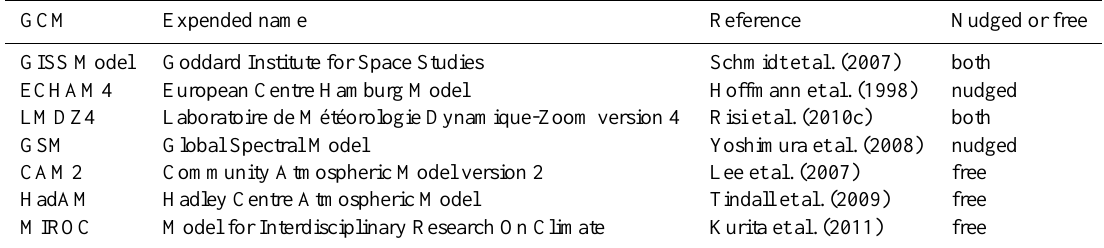
yes than Ducoudré et al. (1993), which leads to an in- crease in the bare soil fraction. Table 2. List of the SWING2 models used in this study, their respective expended names and references for isotopic implementation and simulations. Whether the winds are nudged by reanalyses or not (“free”) is also